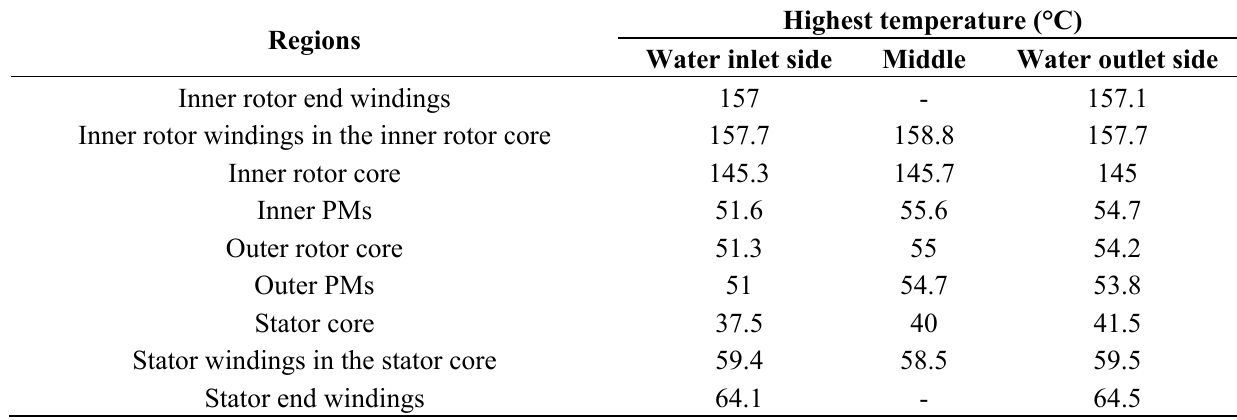
Table 9. Highest temperatures of different parts in the CS-PMSM.